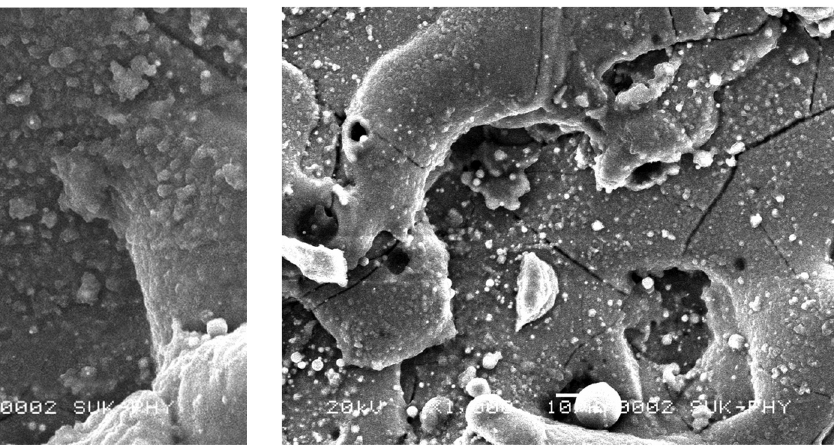
Figure 10: Shape of the craters.